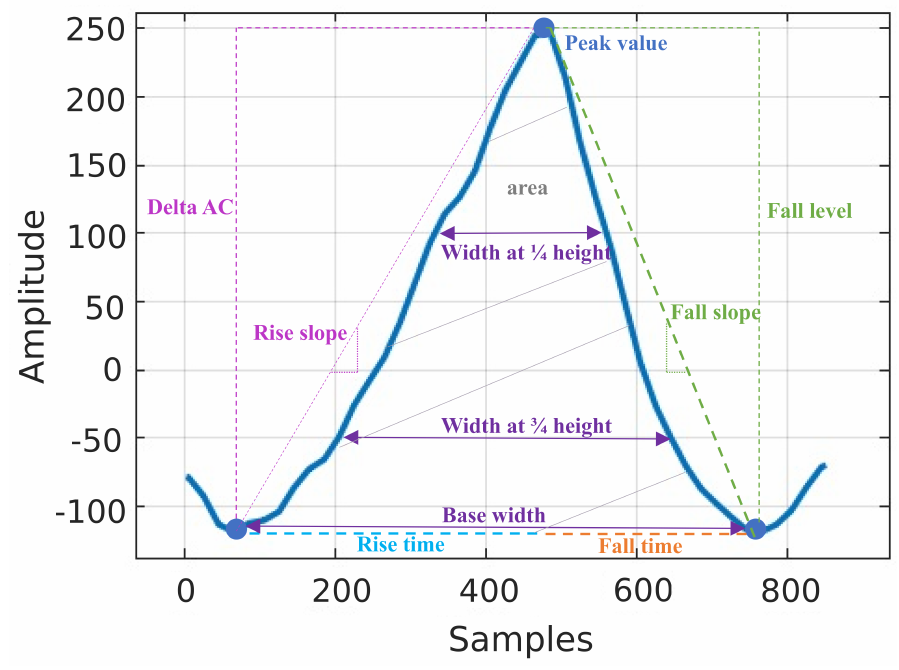
Figure 7. Features extracted from every PPG